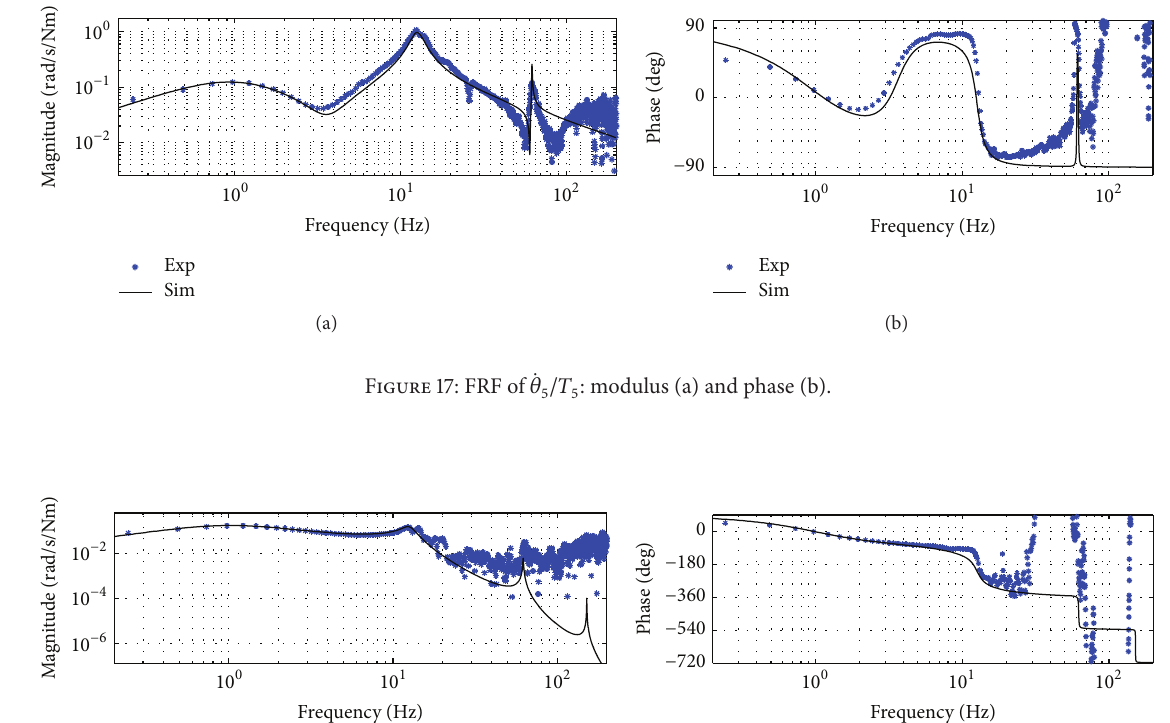
̇𝜃 /𝑇 1 5 : modulus (a) and phase (b).